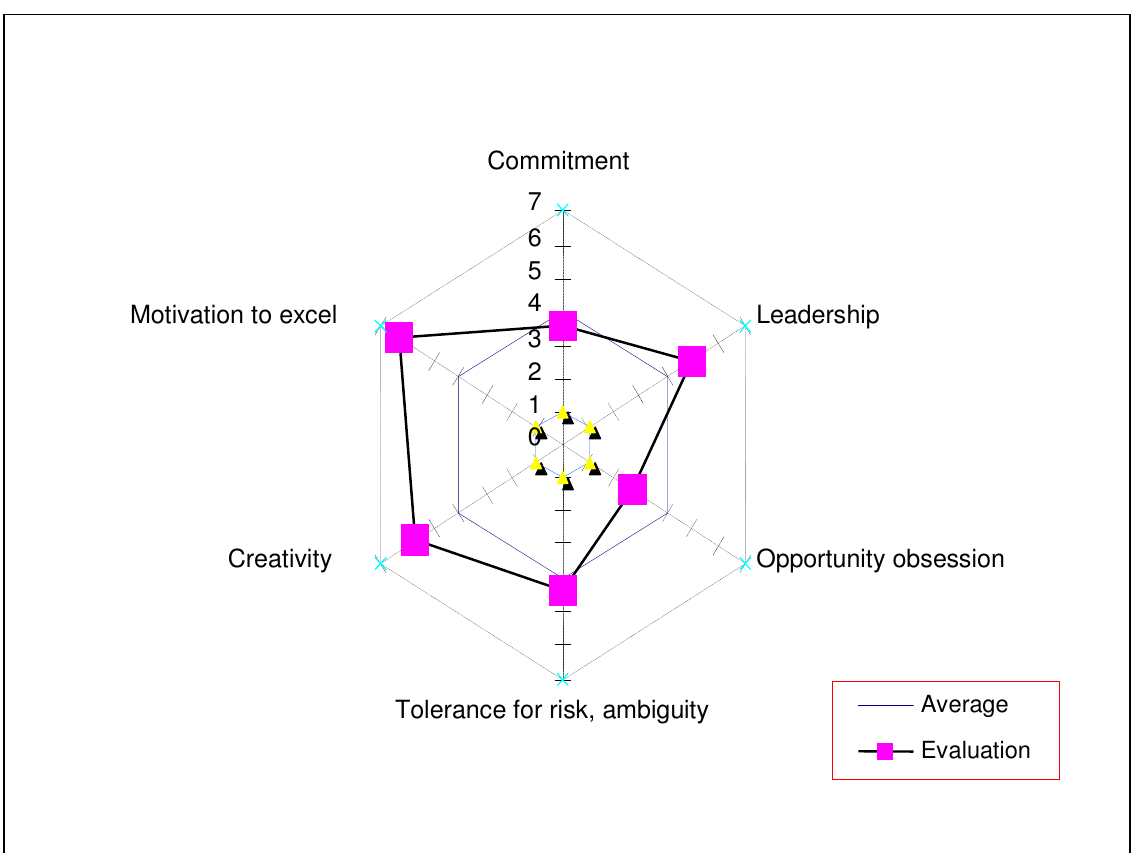
Figure 3: Assessment results for the entrepreneurial success themes